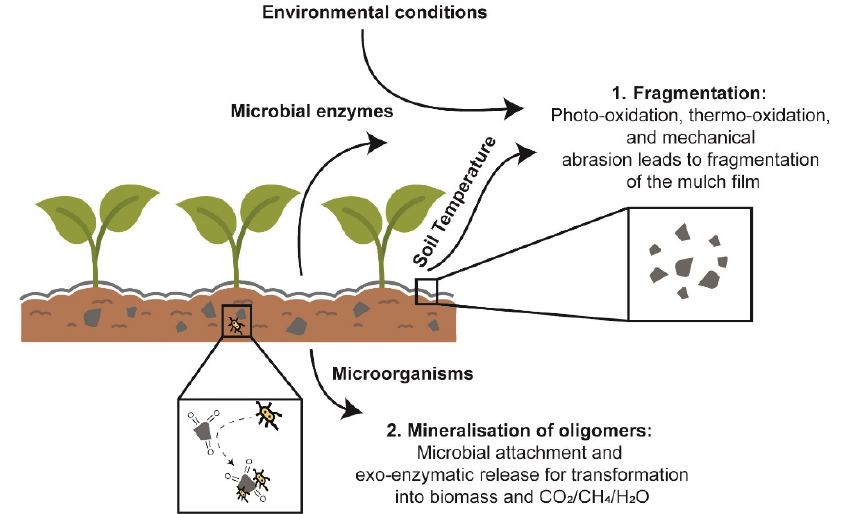
Figure 7. The two steps of biodegradation of mulch films.